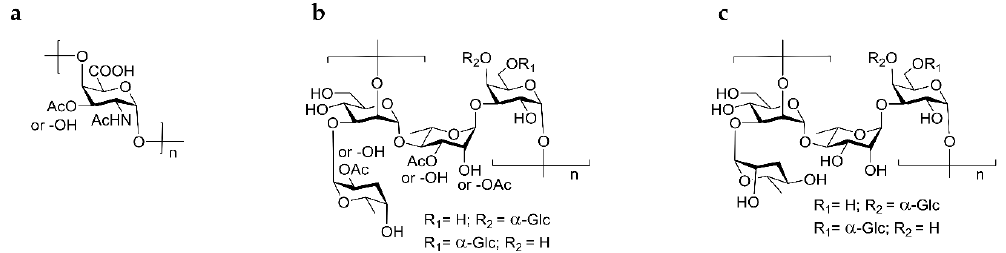
Figure 1. Structures of the repeat units of the trivalent Salmonella glycoconjugate vaccine components. ( a ) S . Typhi Vi capsule polysaccharide; ( b , c ) O polysaccharide repeats from ( b ) S . Typhimurium (serogroup B) and ( c ) S . Enteritidis (serogroup D) O polysaccharides. Adapted from references [1,14].